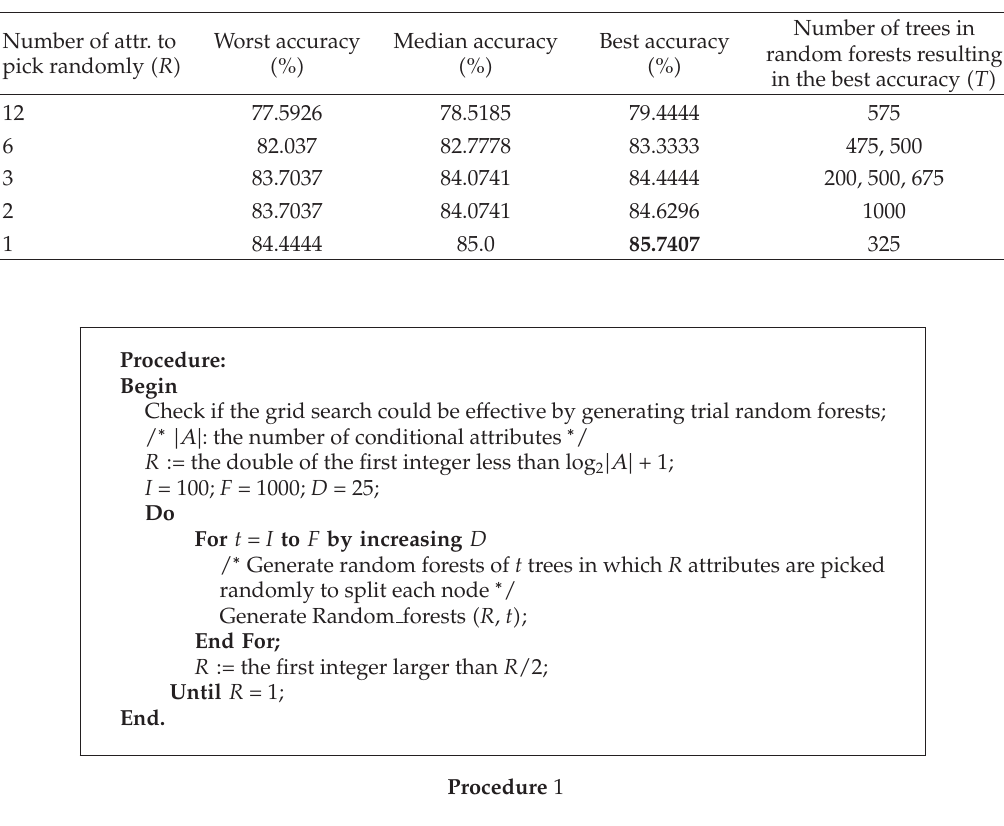
Table 3: The accuracy of random forests for the data set “cylinder